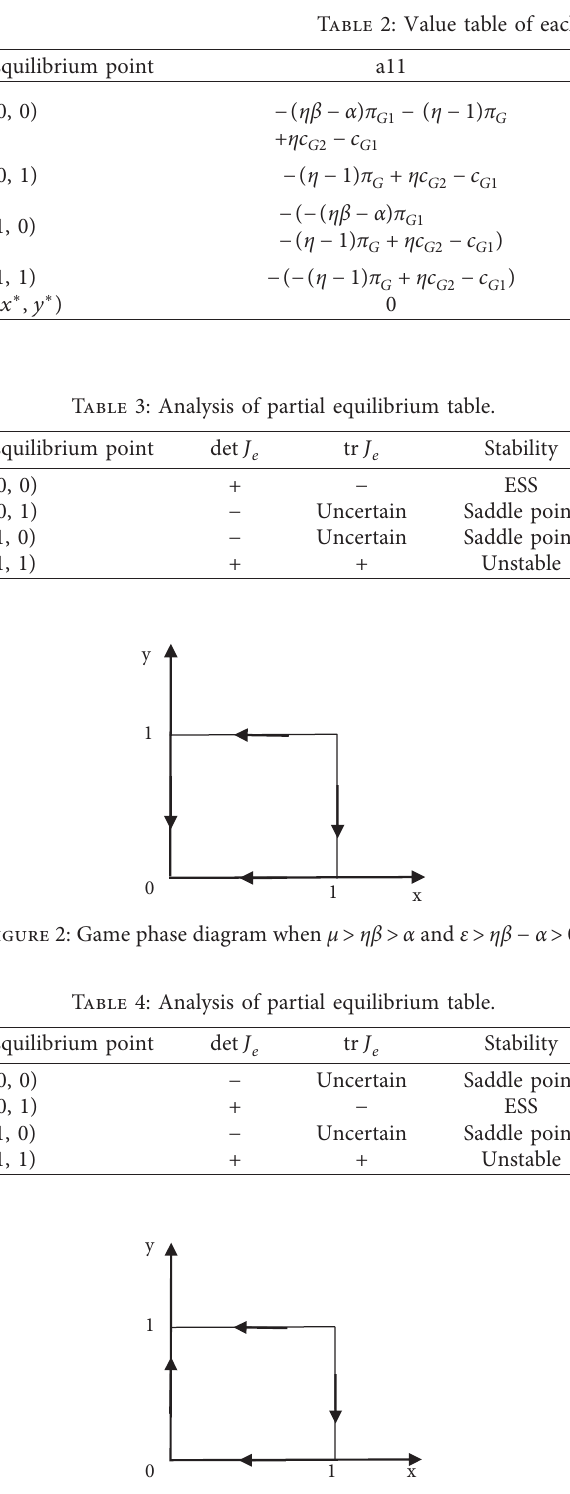
Figure 3: Game phase diagram when ηβ > μ > α and ε > ηβ − α > 0.